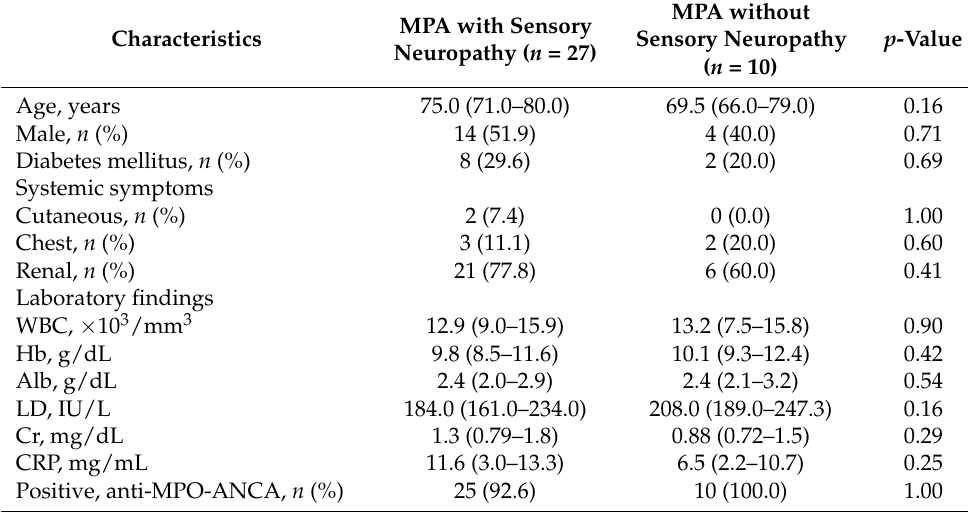
Table 7. Comparison of clinical characteristics between patients with MPA with and without sensory